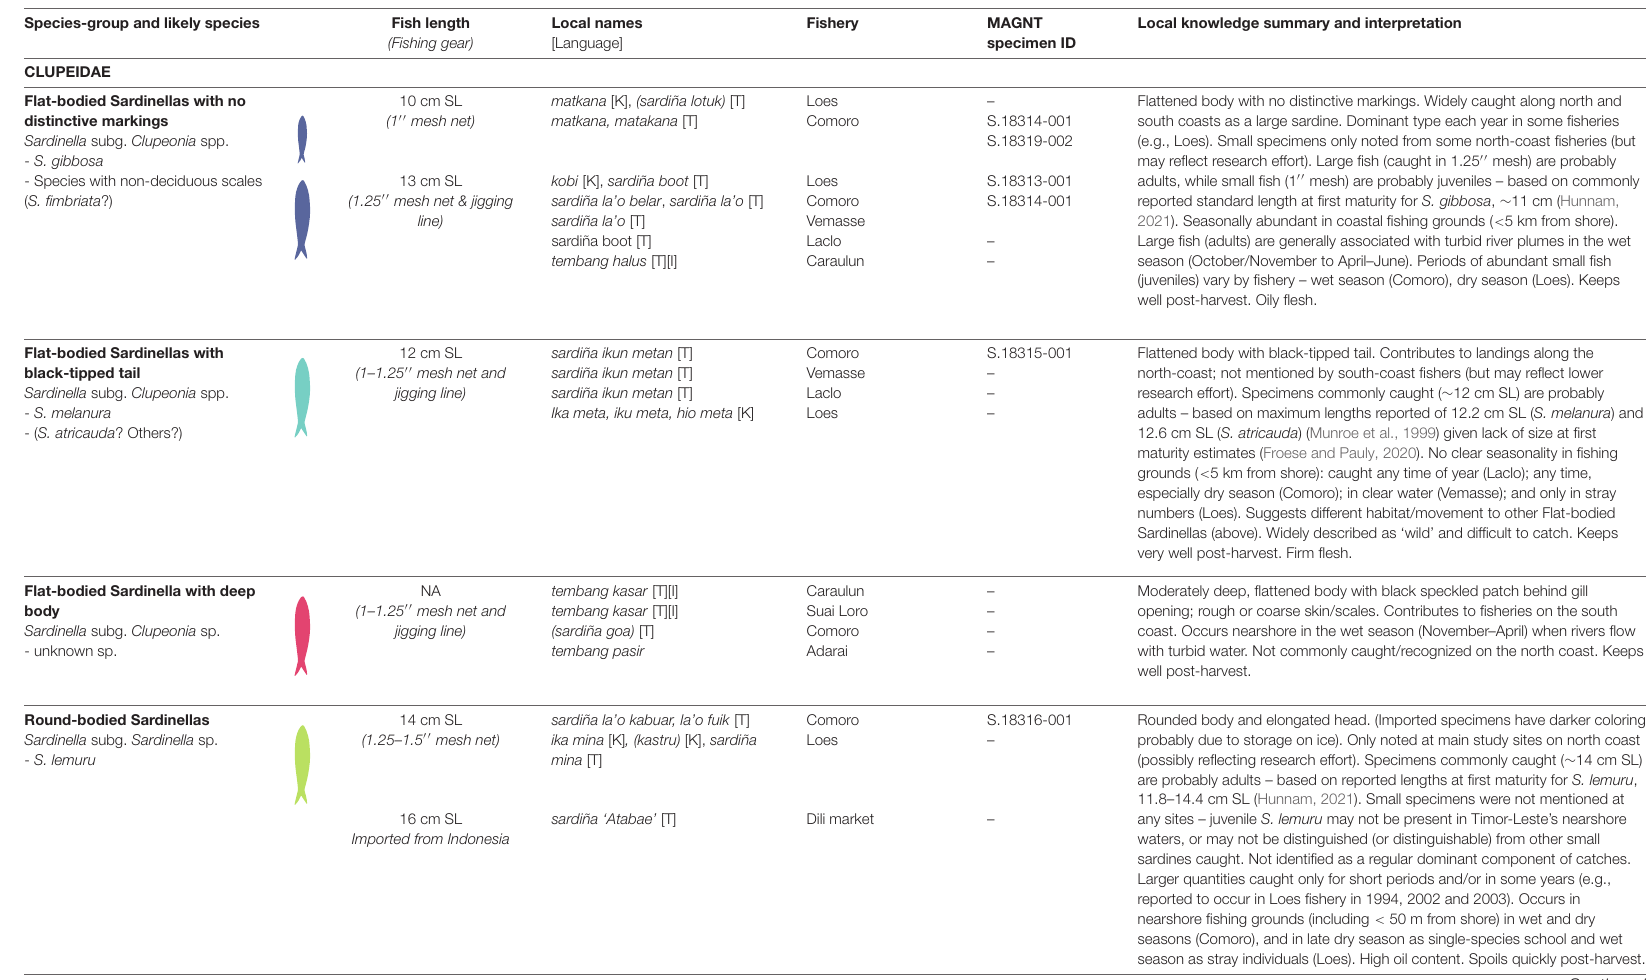
TABLE 1 | Summary of the main tropical sardine species caught in Timor-Leste’s fisheries and local names and knowledge. Species-group and likely species Fish length (Fishing